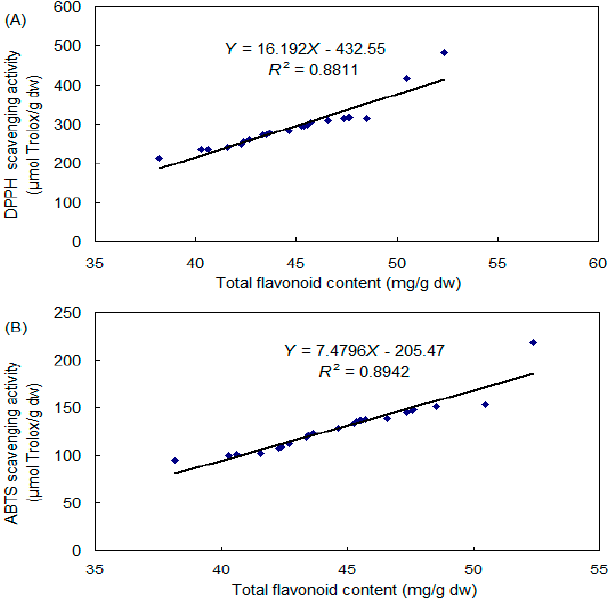
Figure 4. Correlations between flavonoid concentration and DPPH radical scavenging capacity ( A ), and ABTS radical cation scavenging capacity ( B ).